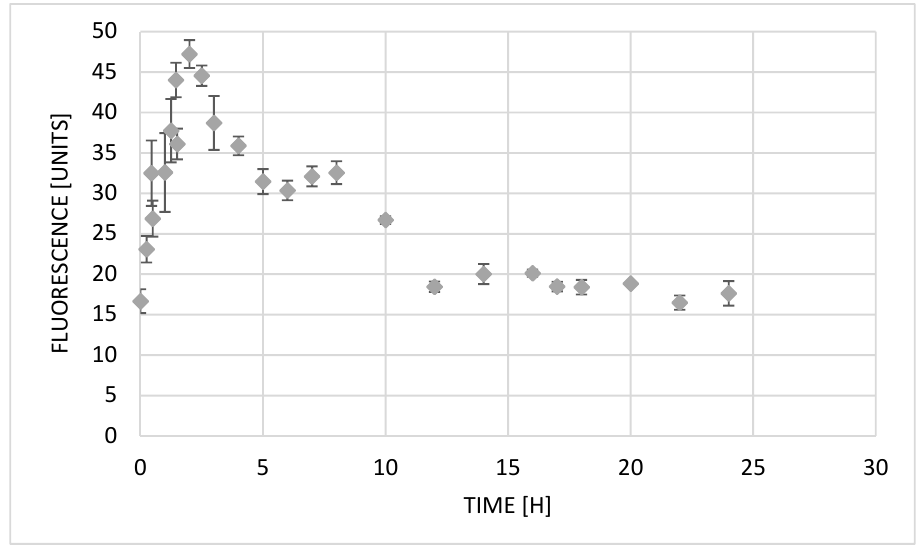
Figure 4. Changes in fluorescence intensity in A549 cells after treatment with olivacine (10 μ M).